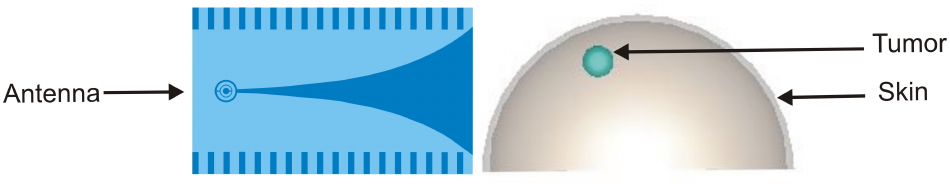
Figure 2. Breast imaging model set up.